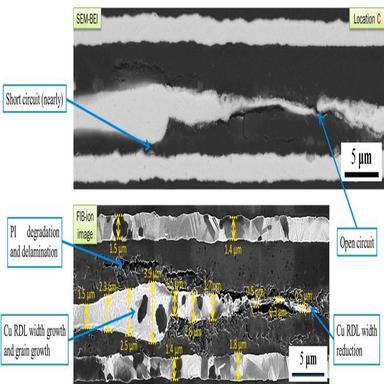
Top-view backscattered (SEM-BEI) and FIB ion-imaging microstructures of the failed Cu interconnect, corresponding to the confined location C in, after the electromigration experiment. (1.5-column; Color online). (For interpretation of the references to color in this figure legend, the reader is referred to the Web version of this article.)